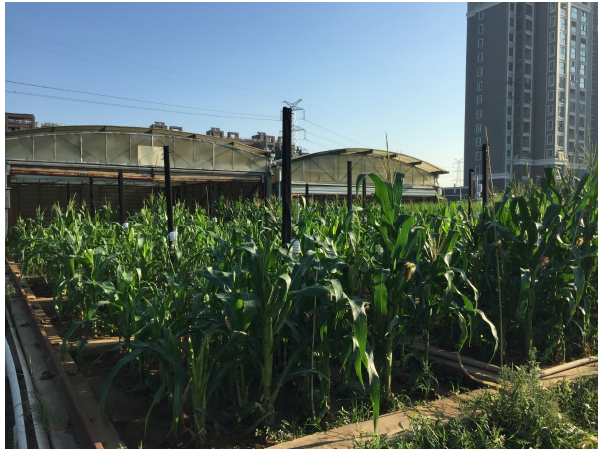
Figure 1. The water and fertilizer observation field of agrometeorological observation and experi- mental station of